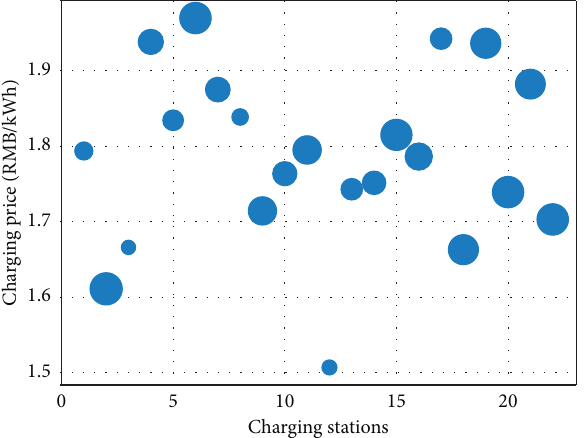
Figure 15: Charging price without optimization.